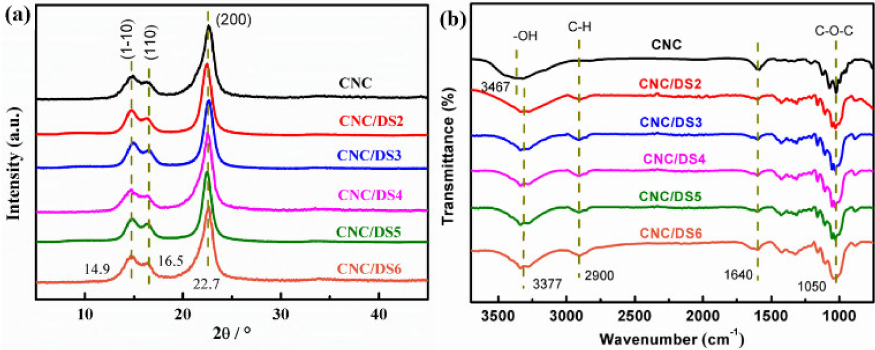
Figure 2. ( a ) XRD of pure CNC and CNC/DS films, ( b ) FT-IR spectra of pure CNC, CNC/DS2, CNC/DS3, CNC/DS4, CNC/DS5, and CNC/DS6 films.